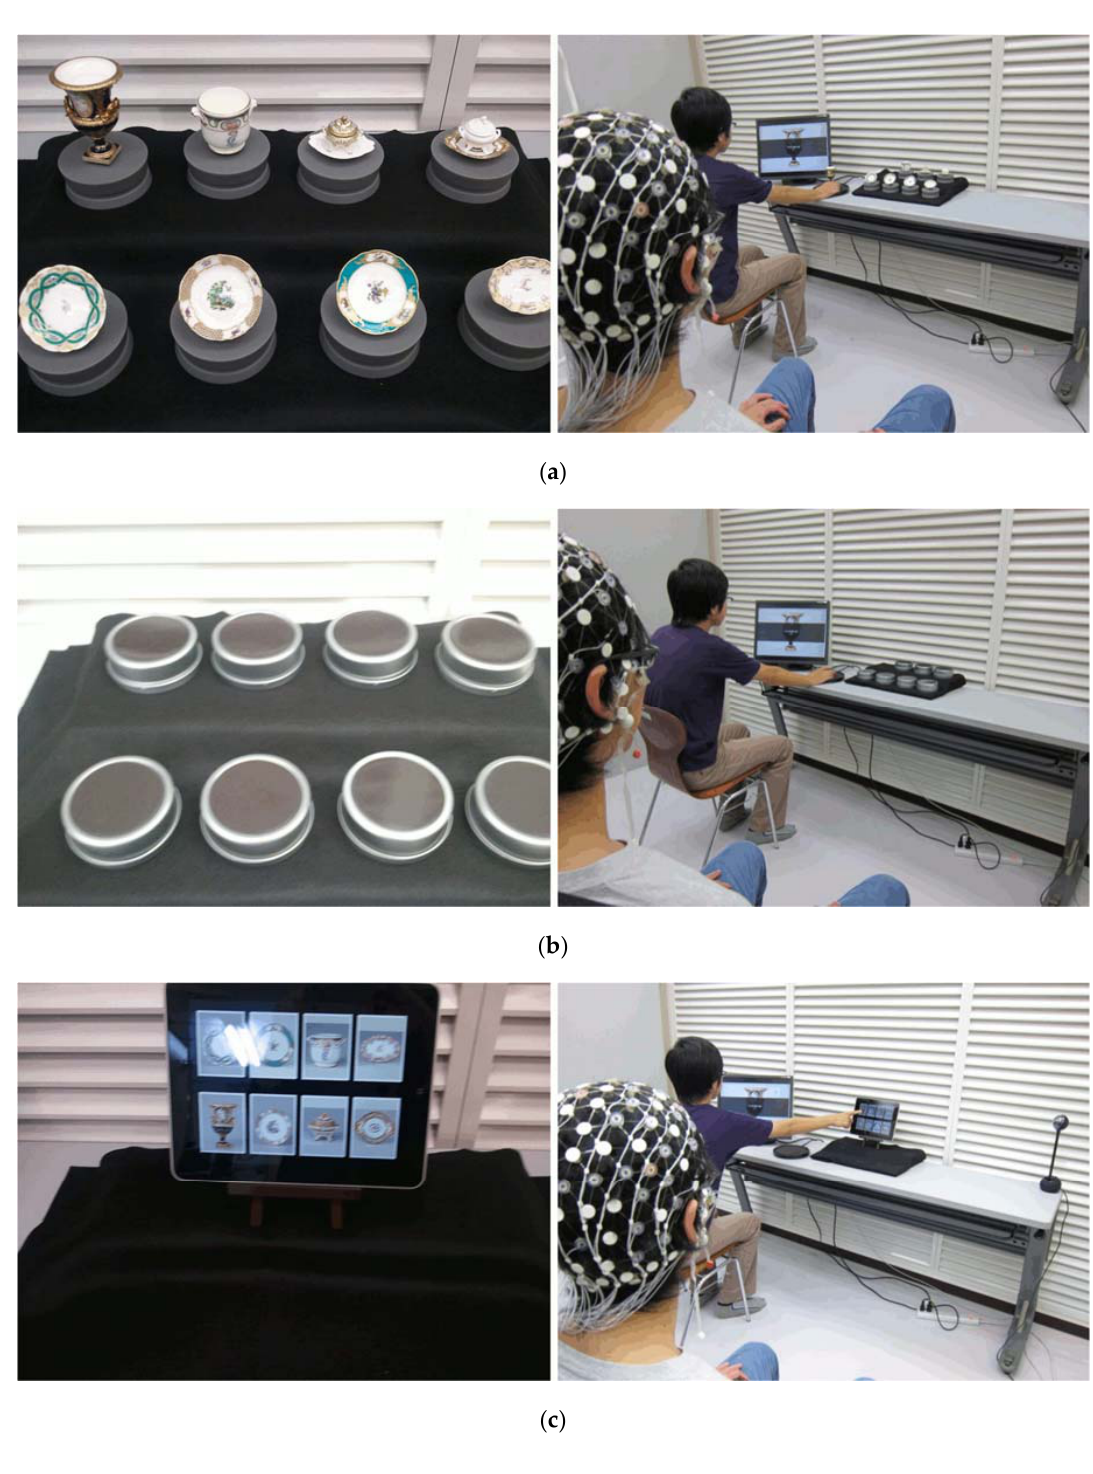
Figure 1. Settings of different conditions in Experiment 1: ( a ) tangible user interface (TUI)/OBJECT condition; ( b ) TUI/CAN condition; ( c ) graphical user interface (GUI) condition.